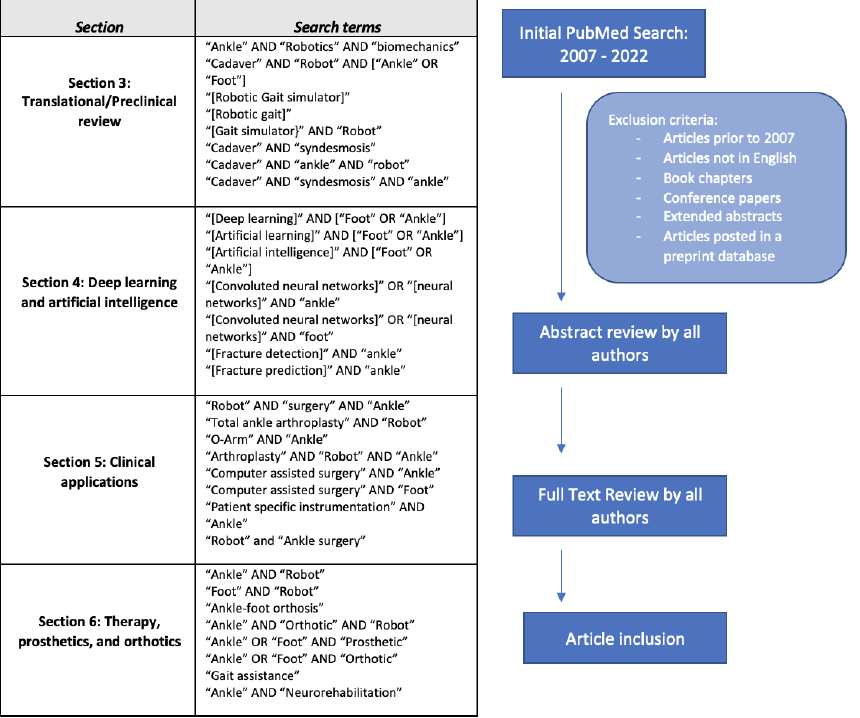
Figure 1. Study Selection Workflow and Search Criteria *. * Schematic was utilized for each respec- tive section